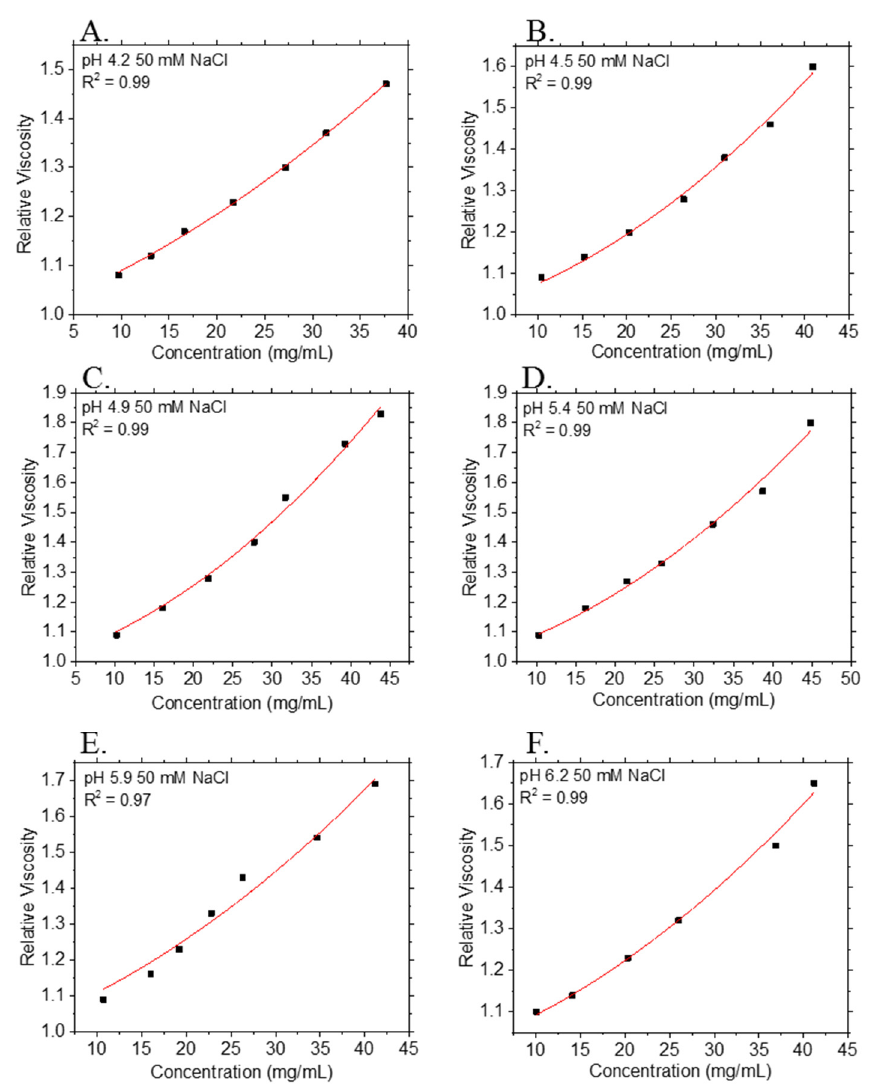
Figure 4. Relative viscosity η R at 25 °C vs. mass concentration ( c 2 ) of mAb-3 formulation in buffers having a range of pH values: ( A ) pH = 4.2; ( B ) pH = 4.5; ( C ) pH = 4.9; ( D ) pH = 5.4; ( E ) pH = 5.9; ( F ) 6.2. Points and curves denote experimental data and non-linear least squares regression fits to Equation (2), respectively. R 2 values for fits are provided in the legends. Each data point is an average of n = 5 measurements, except for data at pH = 5.9: each data point is an average of n = 3 measurements. Although no error bars are displayed, all data points have a percentage relative standard deviation of < 5.0%.